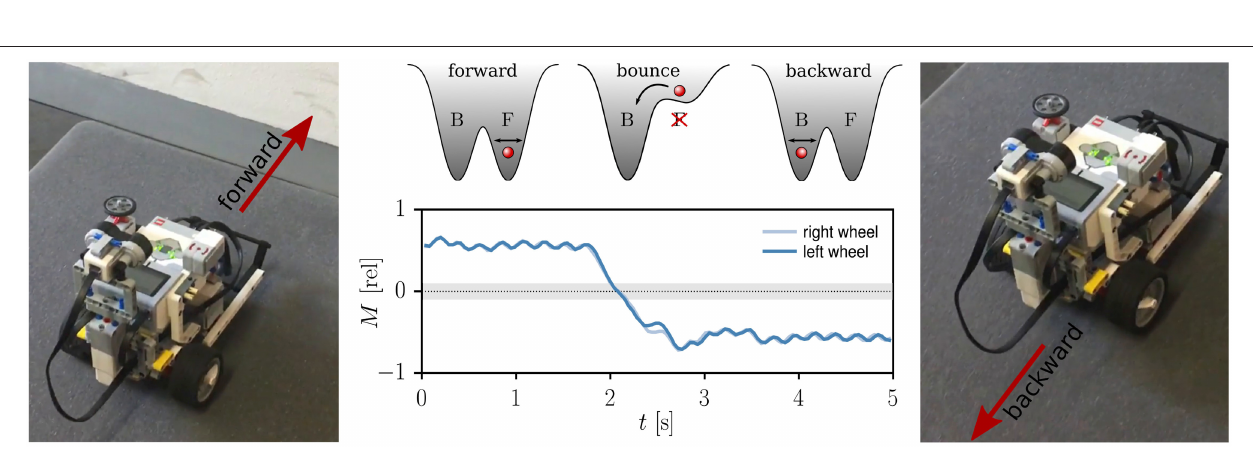
FIGURE 3 | Time series of the motor torques (9) in the chaotic mode, in relative units, for a = 4, τ = 1,000ms and k = 15. Left : For the LEGO robot (click for movie). The light gray shaded area indicates the | M | < M thr ≈ 0.1 region where the motor stalls. Right : For the analytic model (13), with F tan given by the torque on right-hand side of I ˙ ω . Here we took f = 0.5 for the friction and I = 0.05 for the moment of inertia.